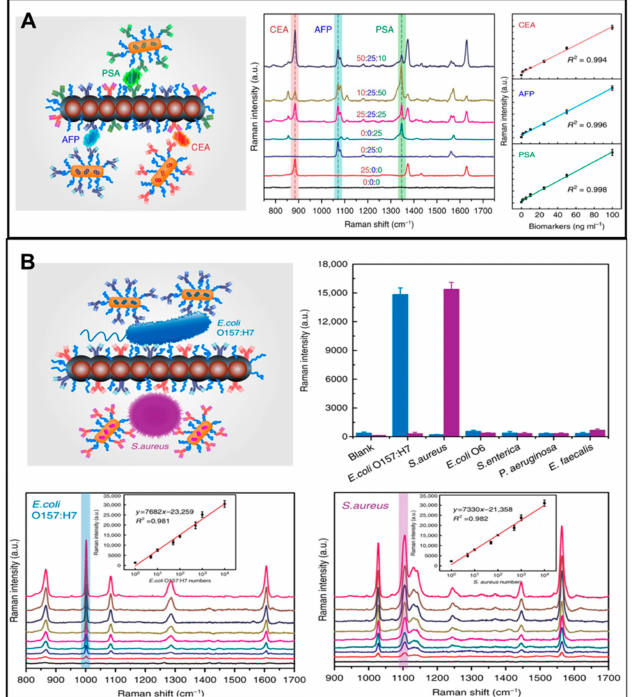
Figure 3. ( A ) Schematic, surface-enhanced Raman scattering (SERS) performance, and corresponding calibration curve with a mixture biomarkers (PSA, AFP, and CEA) at different concentrations from 0 to 100 ng mL − 1 ; ( B ) schematic illustration of in-situ screening of detection of Escherichia coli O157:H7 and Staphylococcus aureus based on an MiChip assay with various concentrations (ranging from 0 to 104 CFU µ L − 1 ) and the results of saliva spiked samples in MiChip assay. Reproduced with permission from Xiong et al.